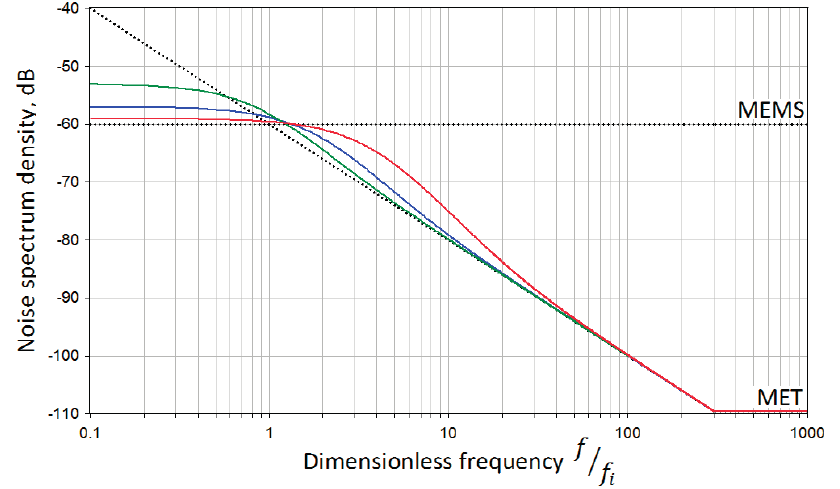
Figure 3. Output noise distribution pattern depending on parameter τ . Black dotted—MET and MEMS noise models; Green—output noise when τ = 1; Blue—output noise when τ = 0.5; Red output noise when τ =